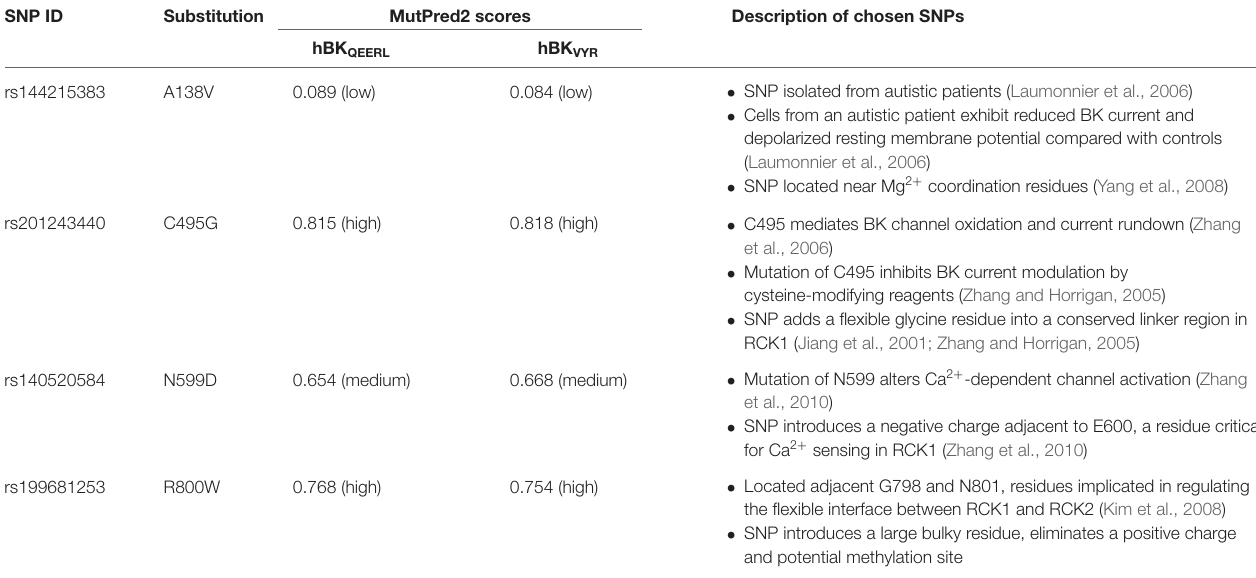
TABLE 1 | Single nucleotide polymorphisms (SNPs) predicted to modulate human BK channel properties.